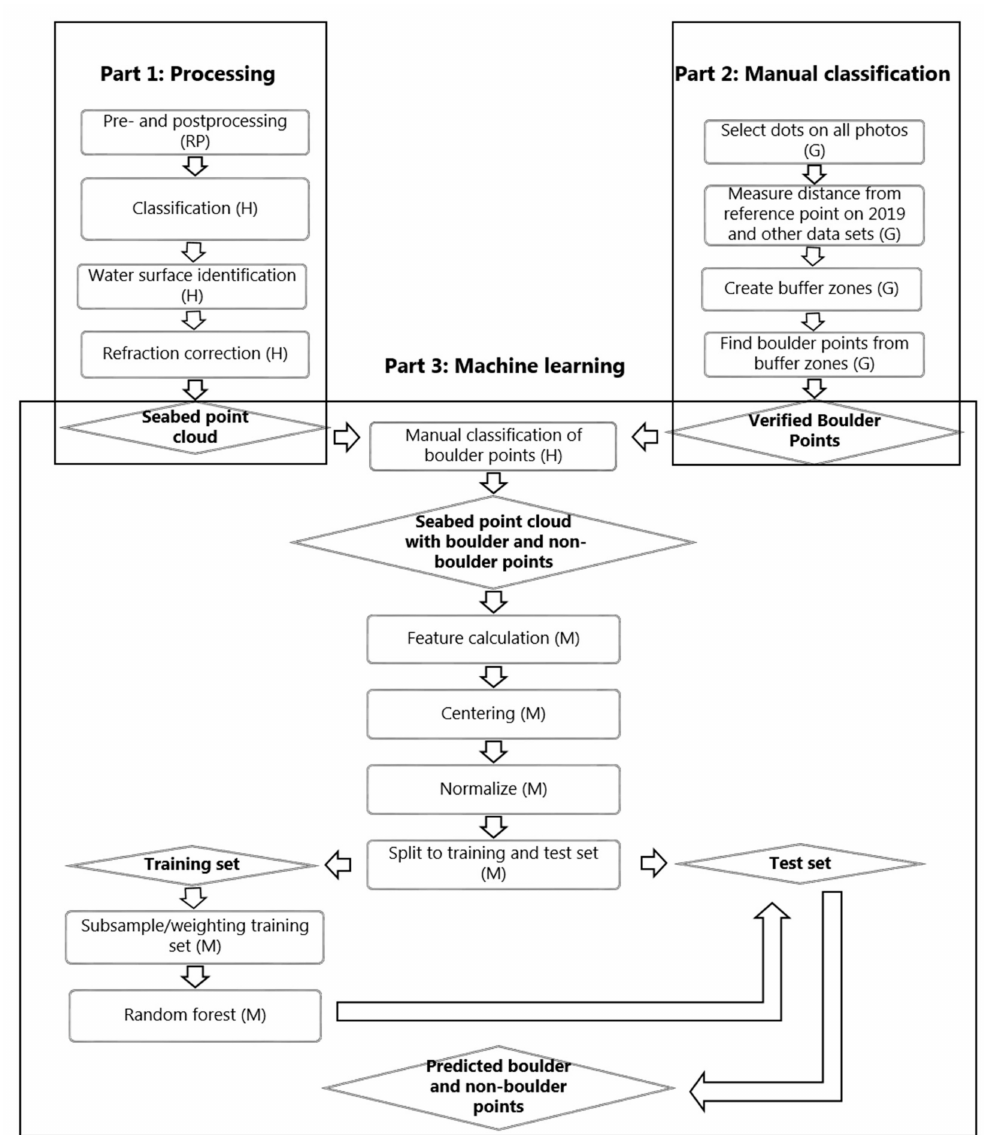
Figure 2. Workflow of the data processing described in the text. Abbreviations: RP = RiProcess, H = HydroVISH, AM = ArcMap, M =